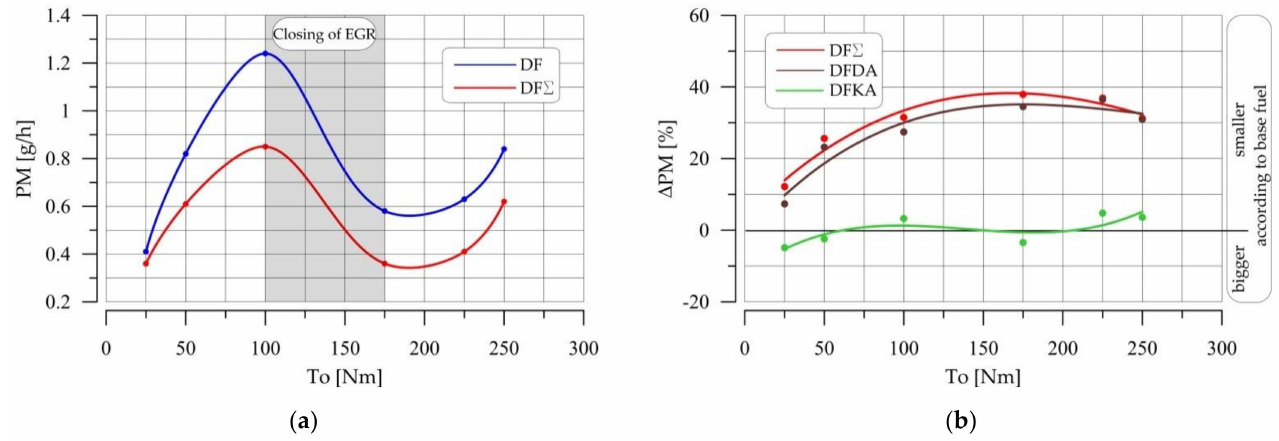
Figure 14. ( a ) Emission of PM in the exhaust fumes vs. engine torque; ( b ) Percentage difference in emission of PM in exhaust fumes vs. engine torque in relation to the base